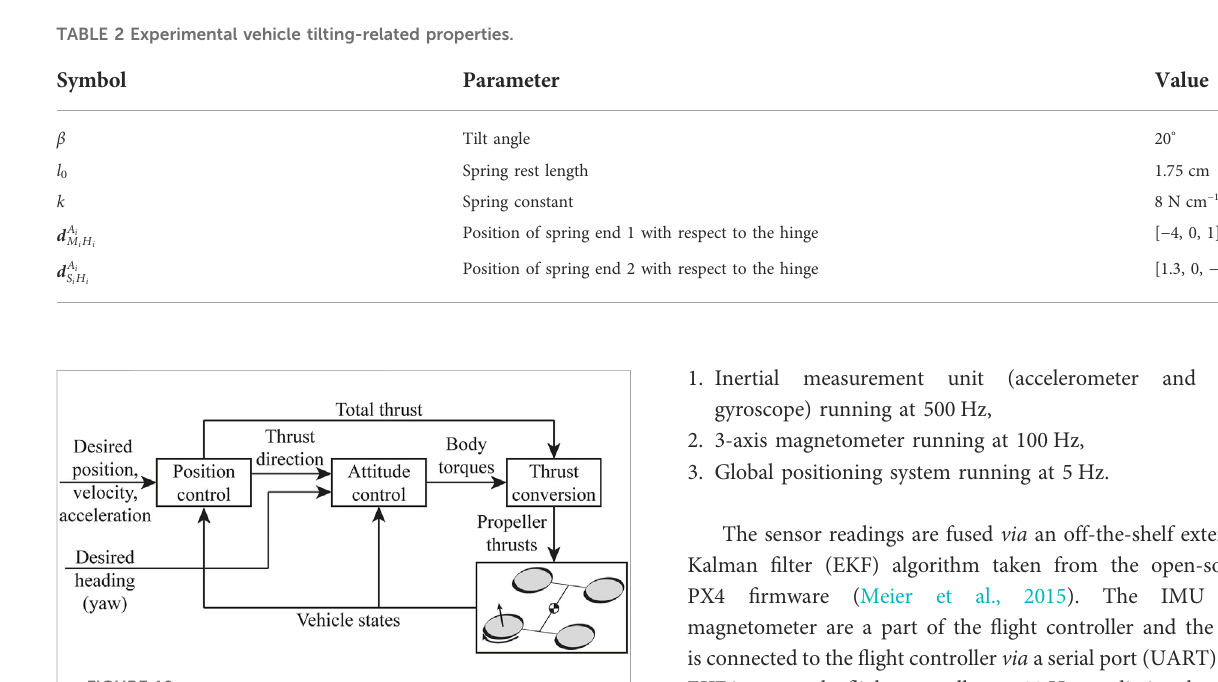
FIGURE 10 Block diagram of the quadcopter